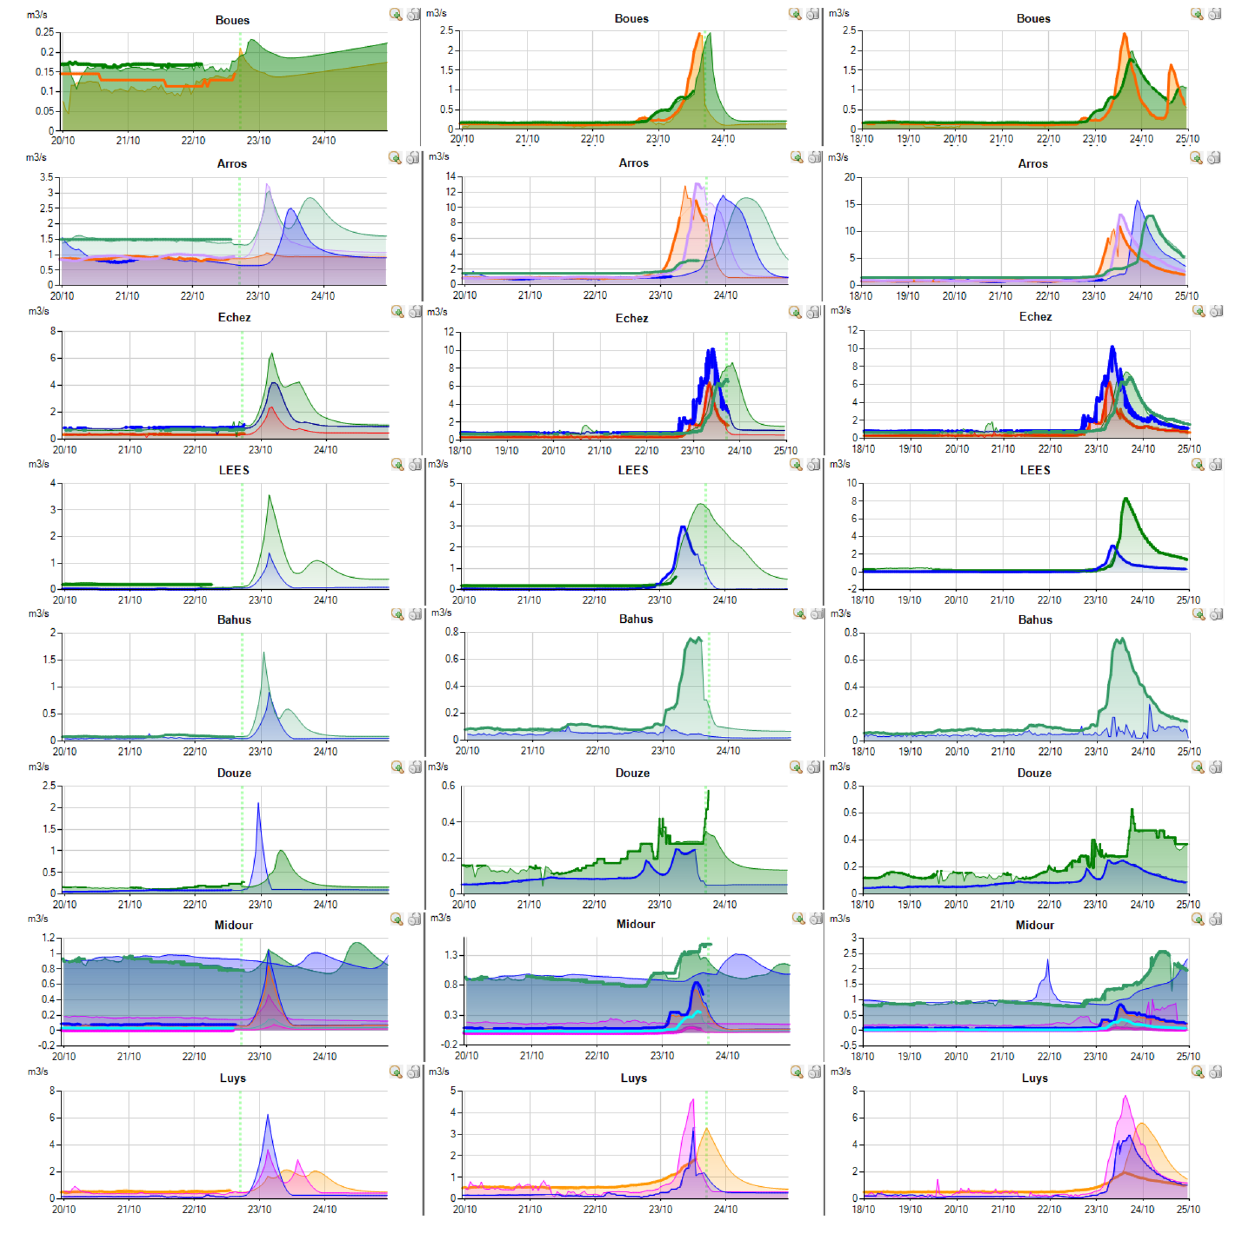
Figure 15. Adour tributaries dashboards